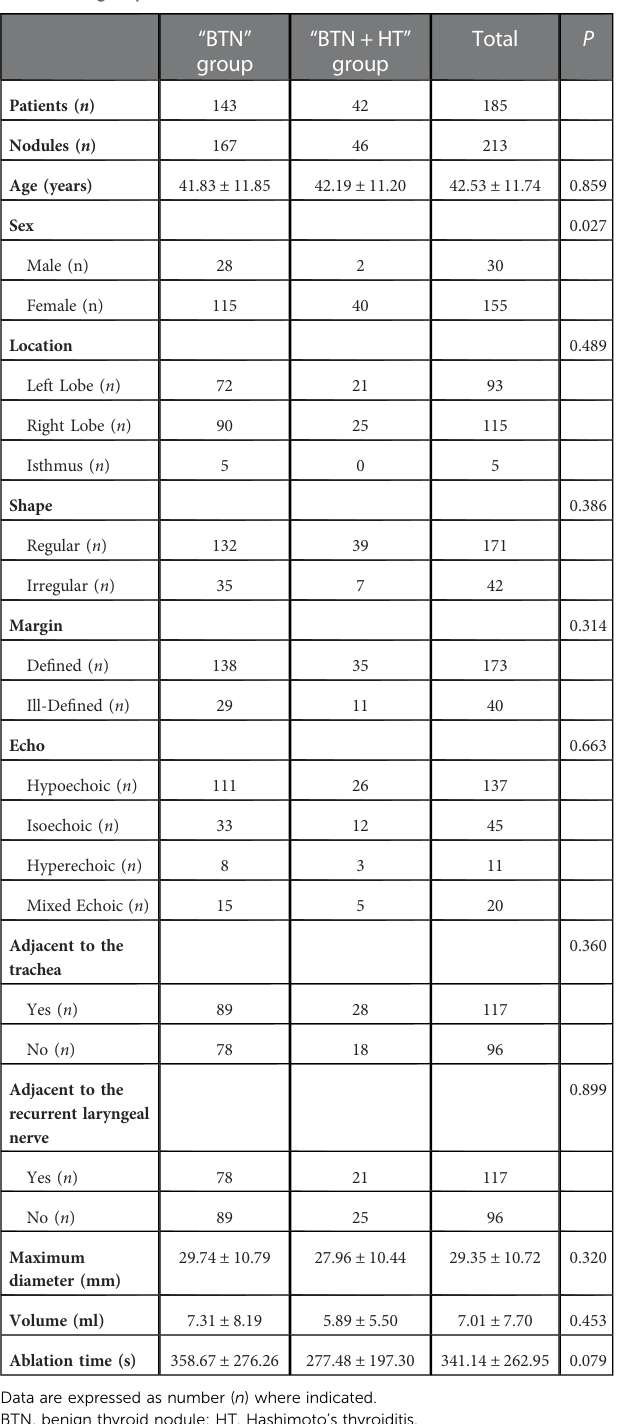
TABLE 1 Comparison of baseline information between the “ BTN ” and “ BTN+HT ” groups.